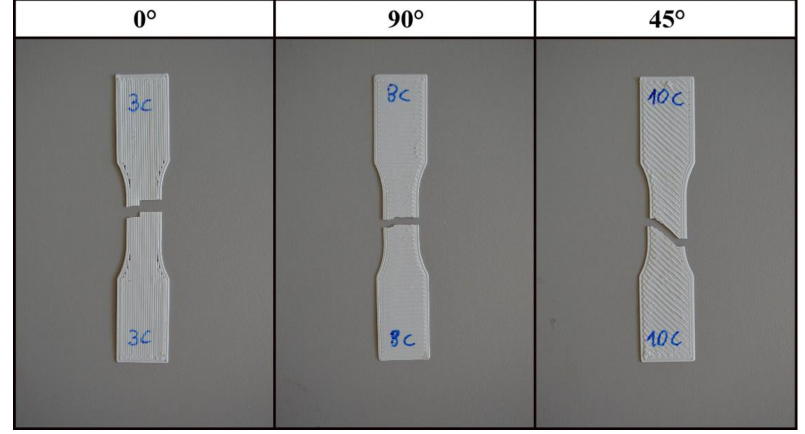
Figure 11. Fracture of single-layer specimens.